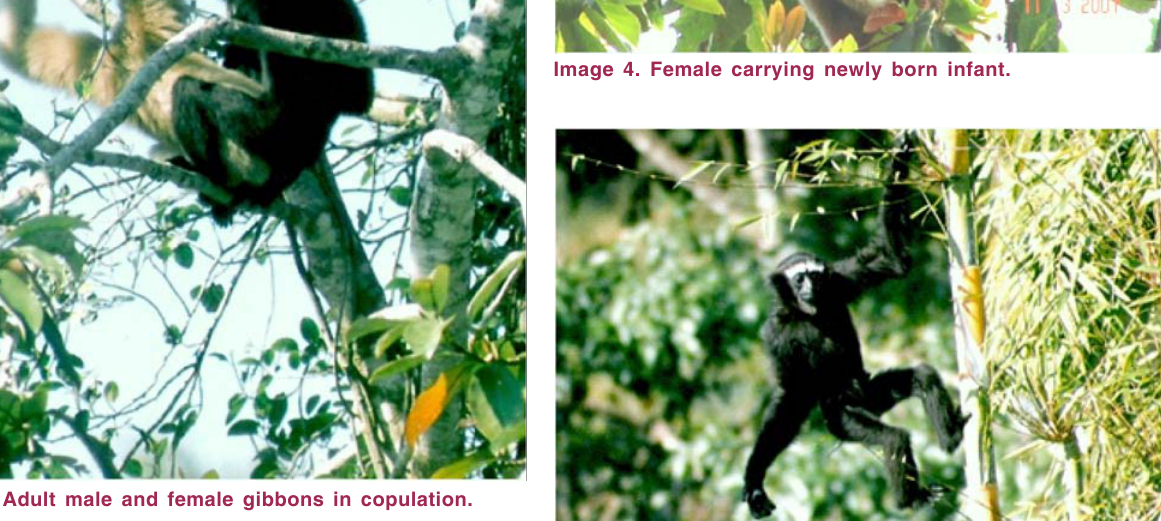
Image 2. Adult male and female gibbons in copulation.